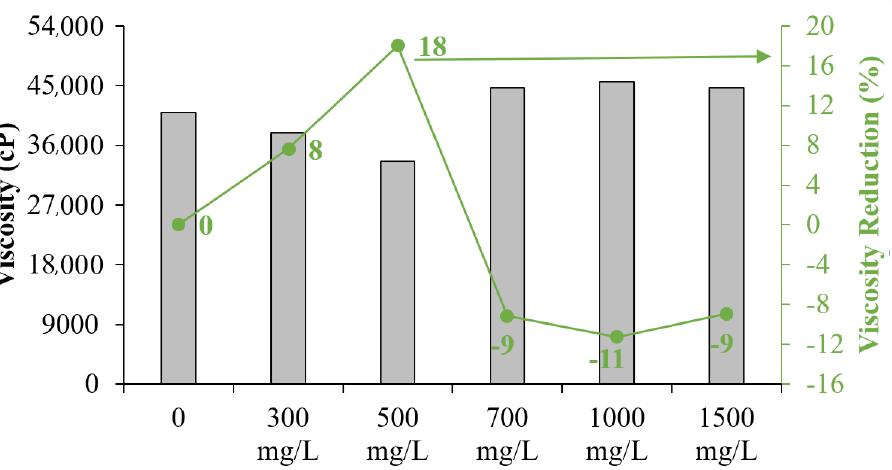
Figure 4. Degree of viscosity reduction for EHO on the presence of CFNS at different dosages, at 25 °C.